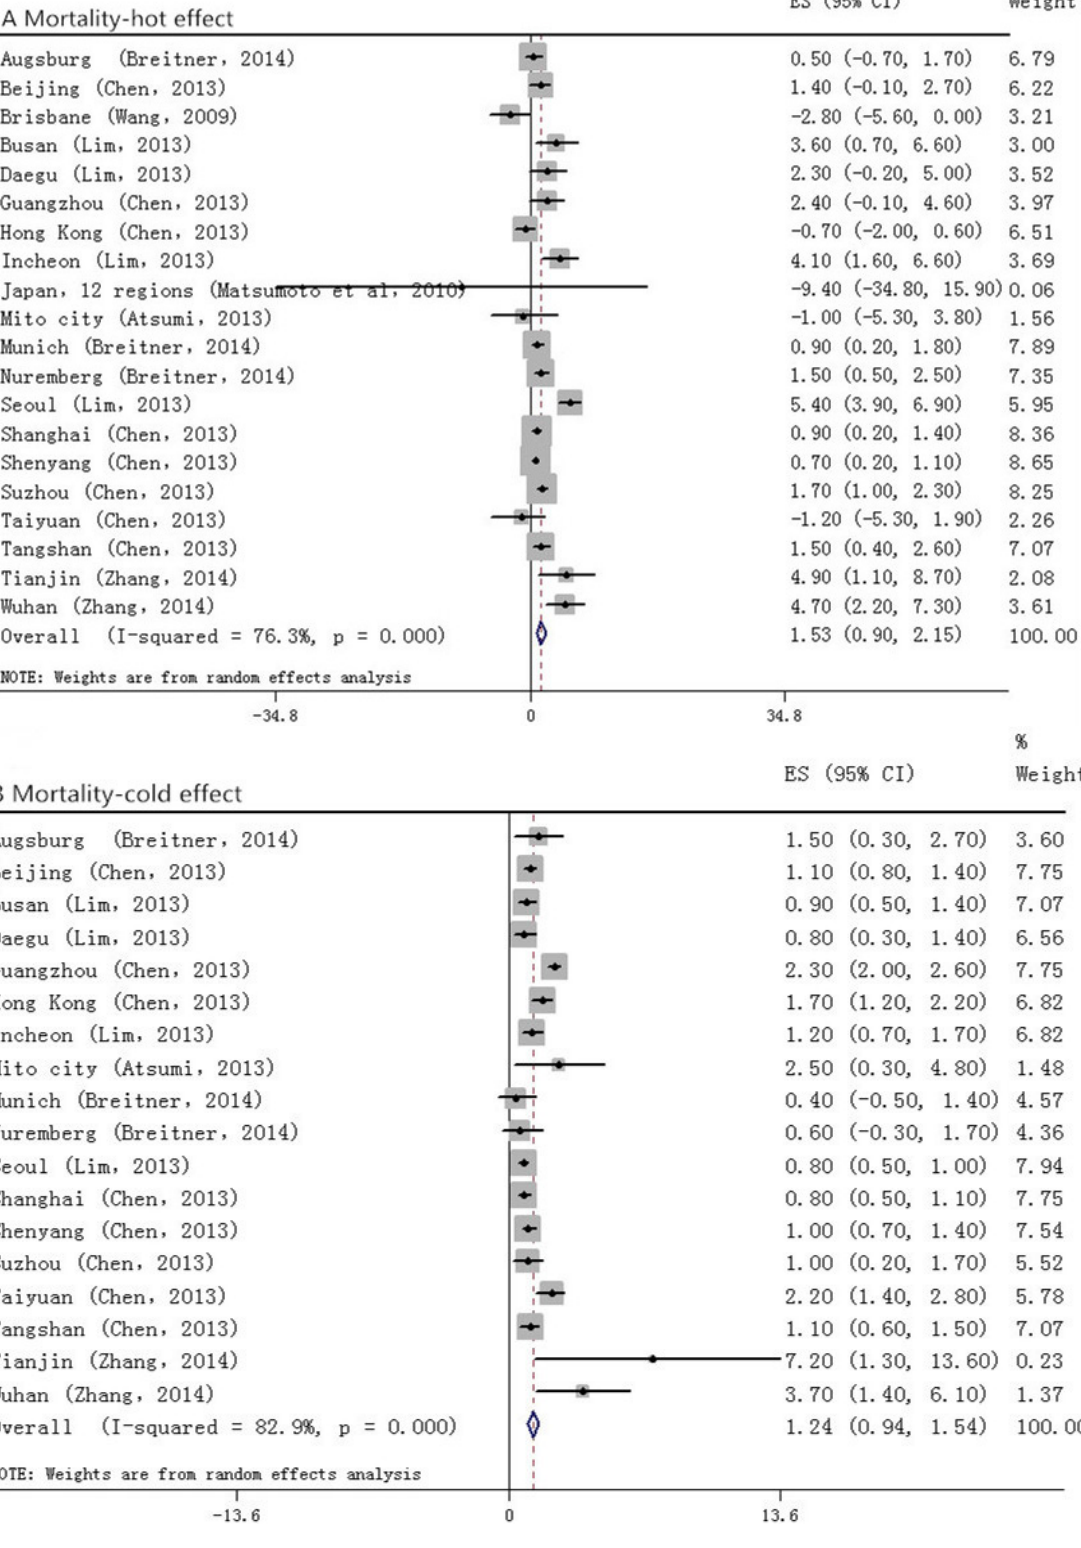
Figure 4. Forrest plots for relationship between the temperature change and stroke mortality. A and B stand for hot and cold effect,